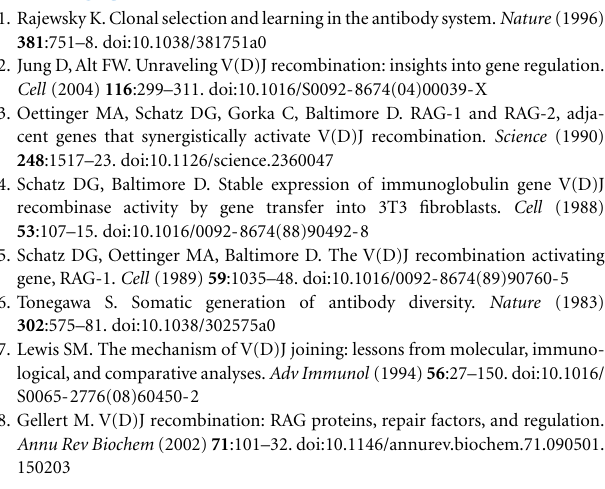
FIGURE 15 |The footprint result splitter . Diagram shows the interface of the Footprint Result Splitter. (A) Button to select the footprint analysis result file. (B) Button to select the output directory. (C) Radio button group to select the criterion for the splitting results, according to theV, D, or J gene family.